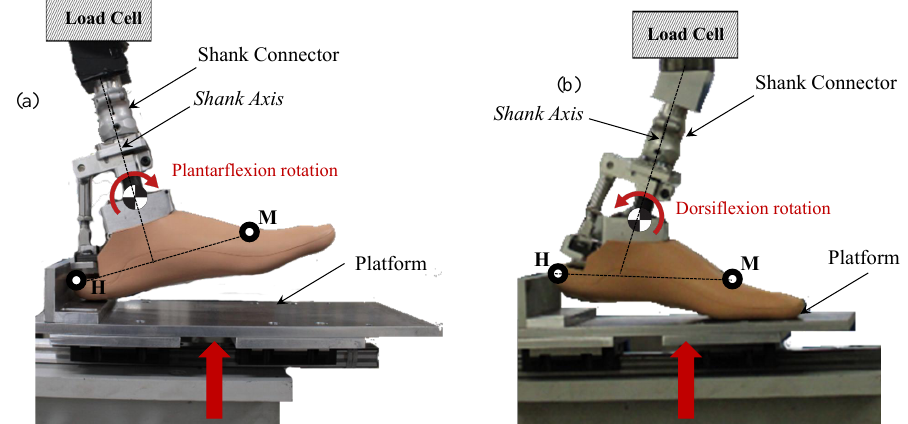
Figure 2. The ISO 10328 equivalent static test: ( a ) plantarflexion test and ( b ) dorsiflexion test